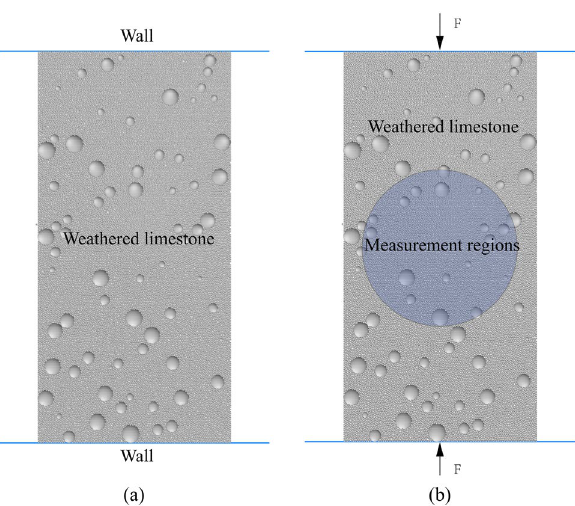
Figure 2. Model diagram ( a ) Initial diagram of model ( b ) Model loading and monitoring